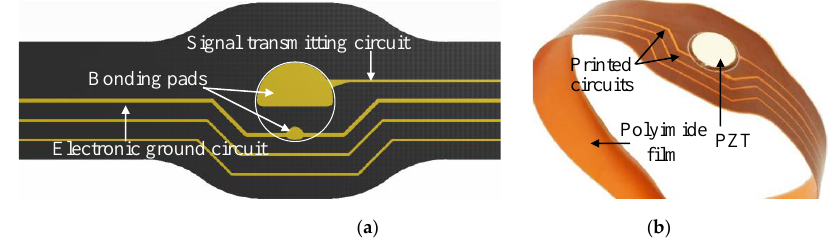
Figure 1. A small section of a developed LPNL. ( a ) The designed FPC. ( b ) The manufactured layer with PZT.